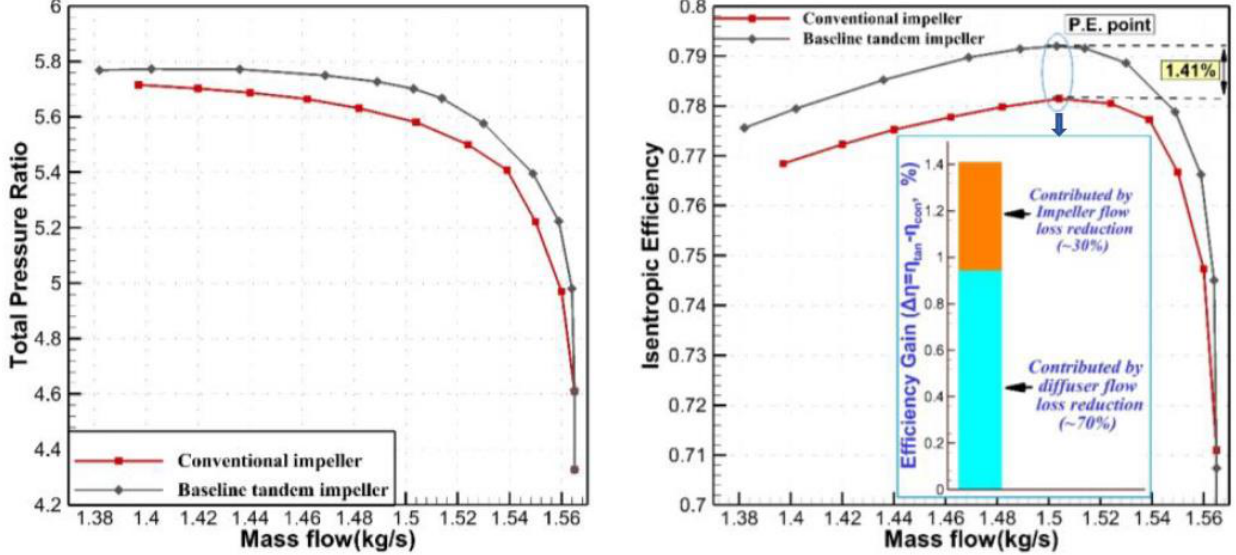
Figure 10. Comparison of the compressor-stage performance with different impeller designs.